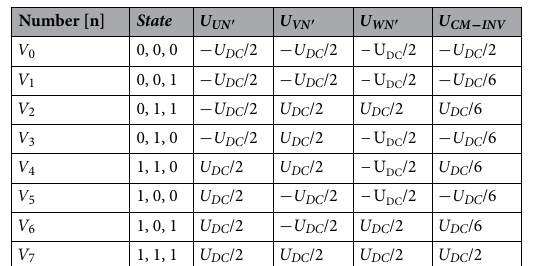
INV depending on the state of V n control vectors 20 . −